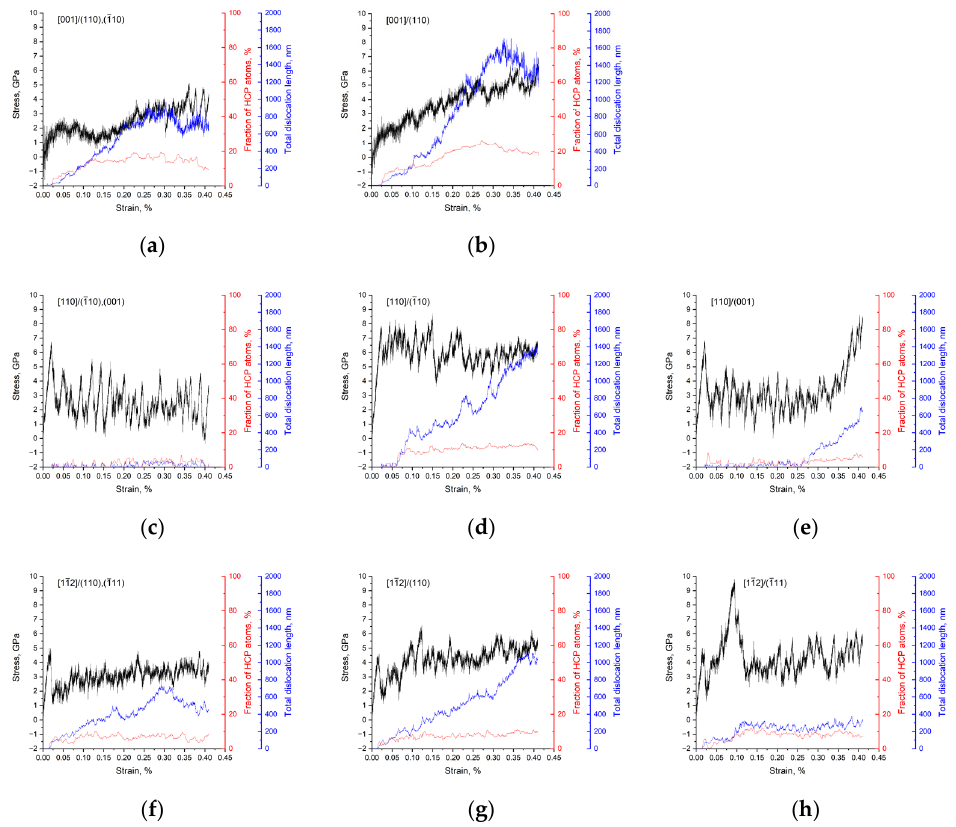
Figure 11. Stress–strain curves, the fraction of atoms in the sites of the HCP lattice, and the length of dislocations depending on the strain: ( a , b ) [001] ‐ single crystals; ( c , d , e ) [110] ‐ single crystals; ( f , g , h ) [112] ‐ single crystals. On the graph, the direction of deformation and the free lateral face (( a , c , f ) four or ( b , d , e , g , h ) one) are indicated.